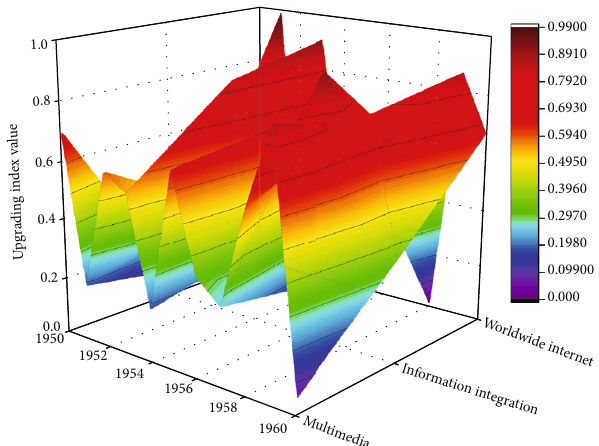
Figure 3: Changes in multimedia usage information during 1950- 1960.